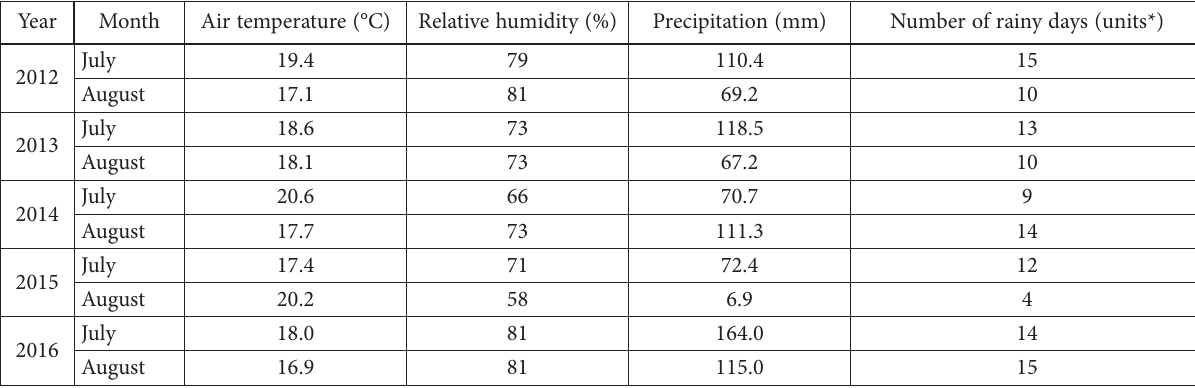
Note : * Precipitation > 0.5 mm